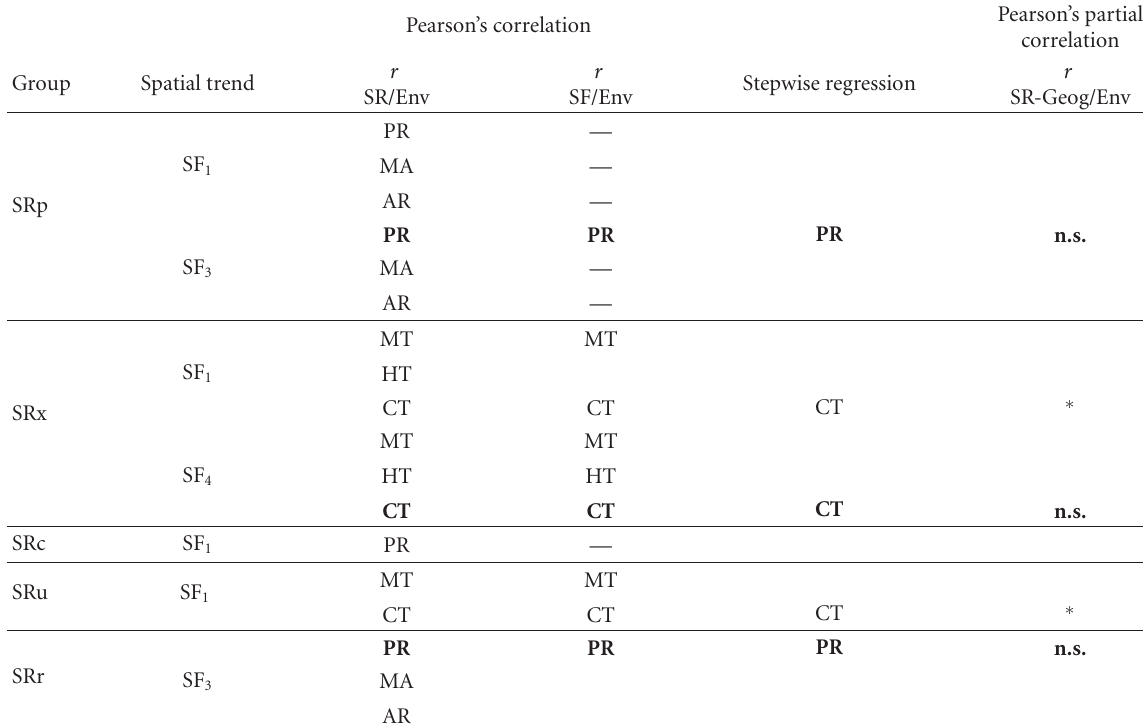
Table 6: A: Partial correlation coe ffi cients between SR and the geographical trends (Latitude and NNE-SSW axis) controlling for spatial variables (SF 1 , SF 3 , SF 4 ). B: Partial correlation coe ffi cients between SR and the spatial variables (SF 1 , SF 3 , SF 4 ) controlling for the geographical variables (Latitude and NNE-SSW